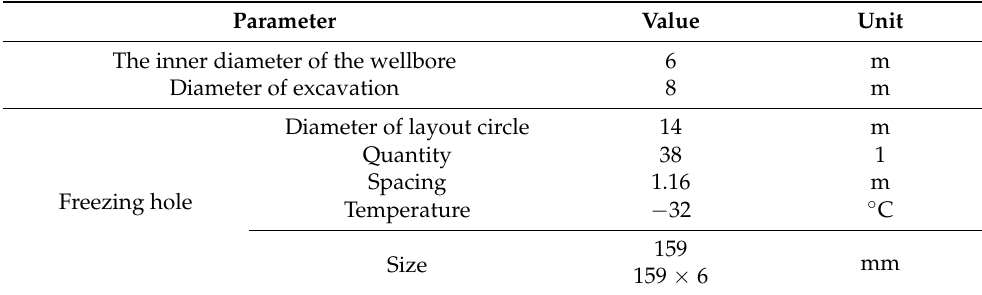
Table 6. Freezing parameters of central wind shaft in Panyi